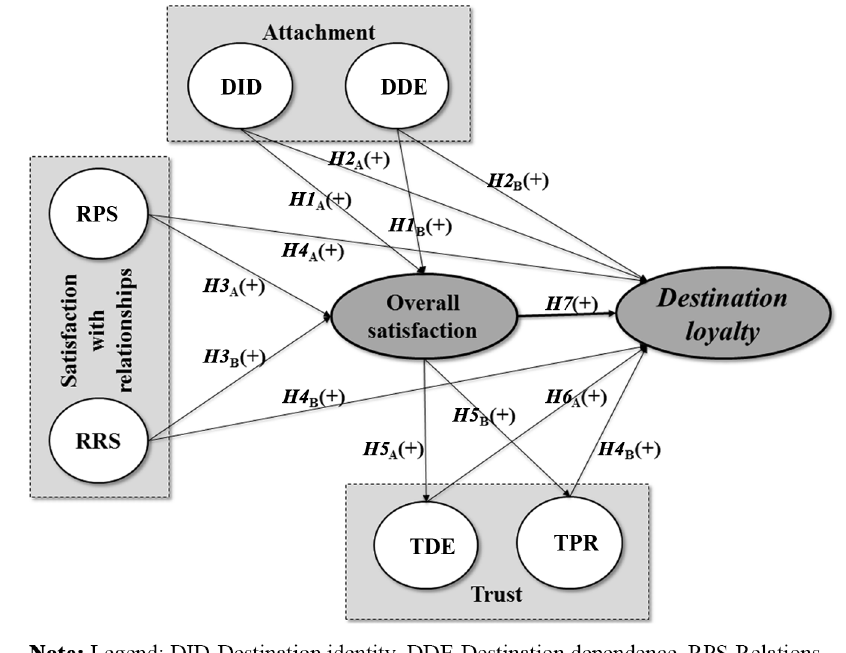
Figure 1. Theoretical